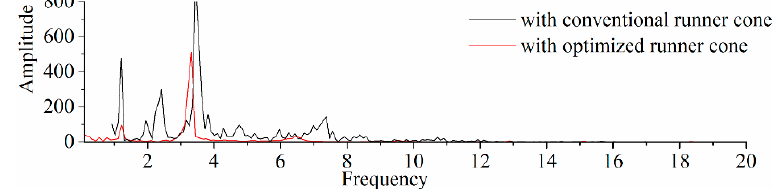
Figure 6. Pressure fluctuations at σ = 0.03.